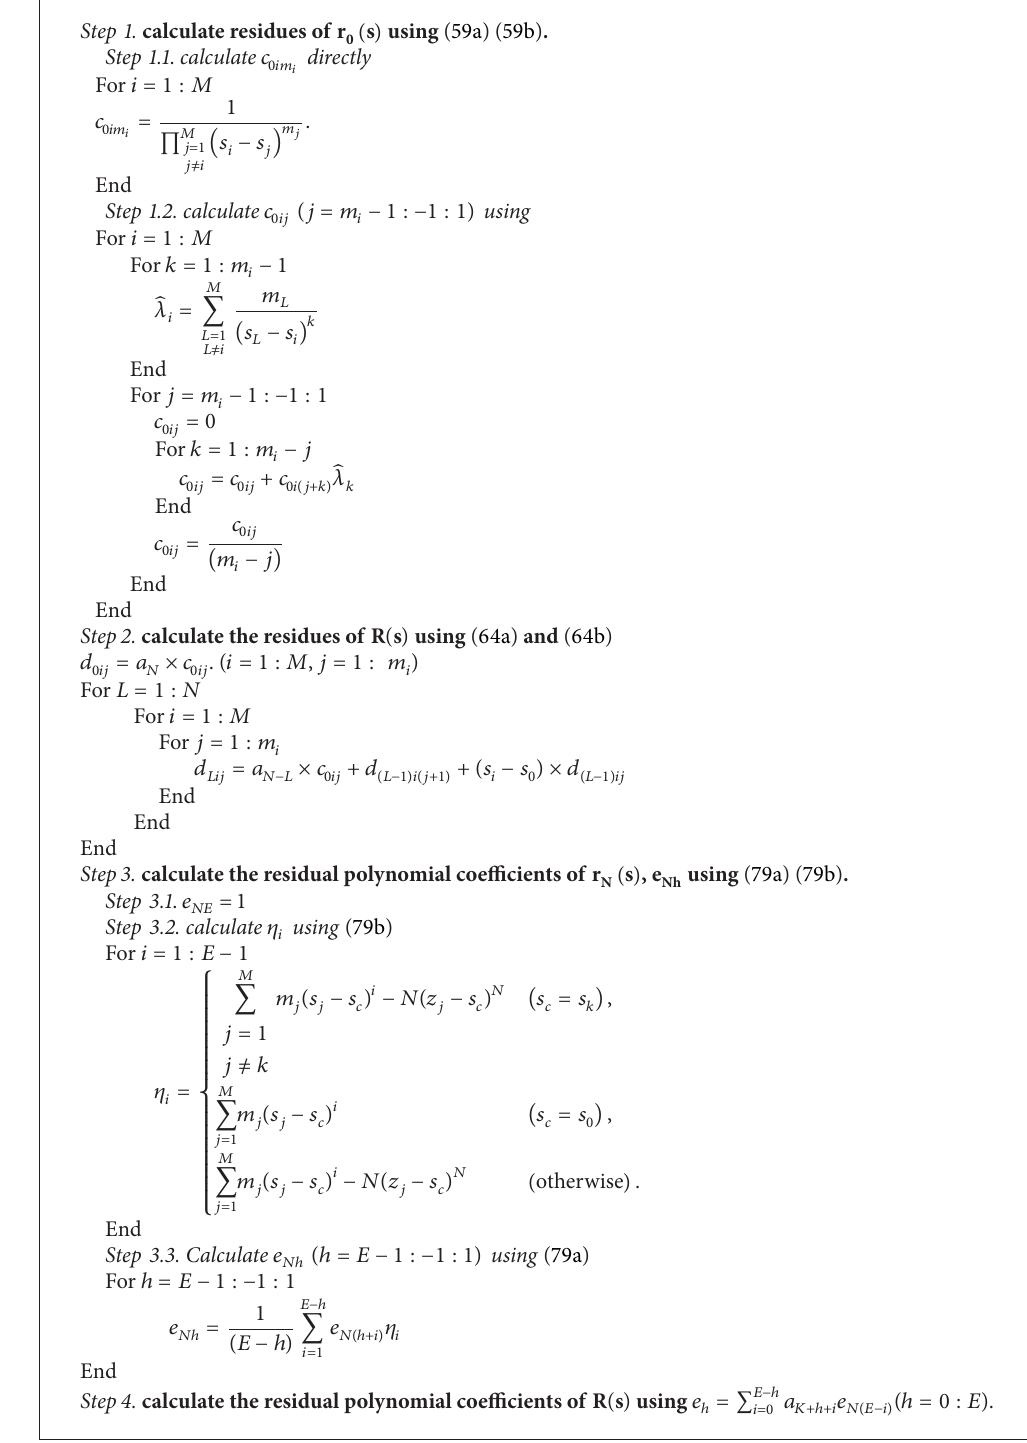
Algorithm 2: Algorithm for functions in expanded